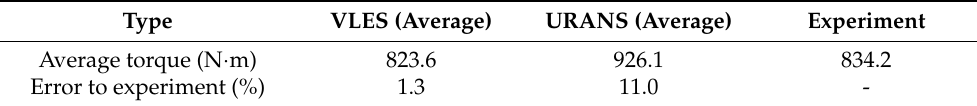
Table 3. Comparison of CFD torque values with experimental data (wind speed = 7 m/s).